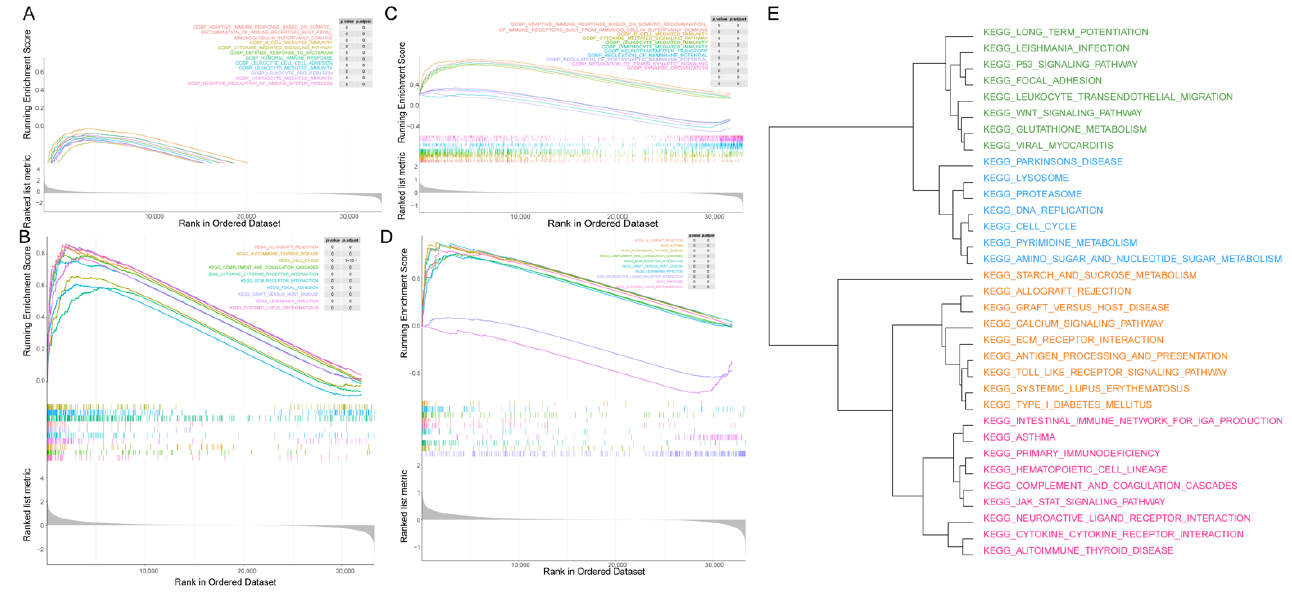
Figure 5. GSEA results related to the prognosis of patient: ( A ) top 10 GO items enriched by high- and low-risk groups; ( B ) top 10 KEGG items enriched by high- and low-risk groups; ( C ) top 10 GO items enriched by patients with survival times longer and shorter than 5 years; ( D ) top 10 KEGG items enriched by patients with survival times longer and shorter than 5 years; and ( E ) clustering tree of shared KEGG pathways.